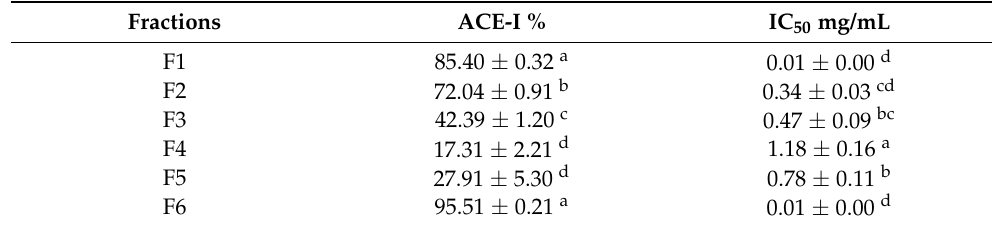
Table 1. The percentage ACE-inhibitory activity and IC 50 mg/mL (means ± SE) of fermented 12% skim milk peptide